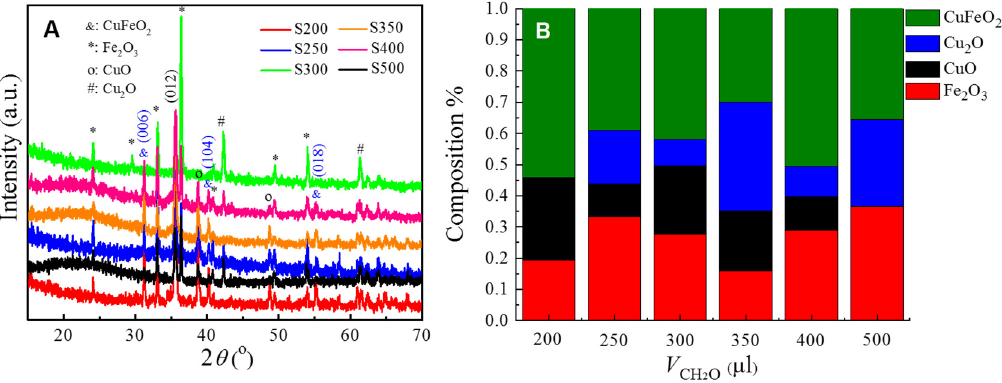
Figure 2. ( A ) The XRD patterns of the six samples S200 to S500. The diffraction peaks from CuFeO 2 , CuO, Cu 2 O, and Fe 2 O 3 are indicated in the plot. ( B ) The relative compositions of CuFeO 2 , CuO, Cu 2 O, and Fe 2 O 3 in each samples extracted from the Rietveld program.